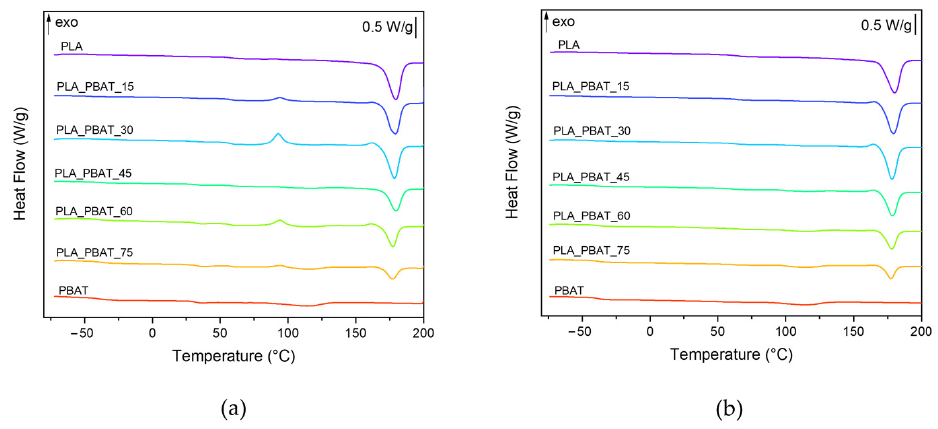
Figure 6. DSC thermograms of neat PLA, neat PBAT and PLA/PBAT blends. ( a ) First heating scan, ( b ) second heating scan. Table 3. Results of the DSC tests on neat PLA, neat PBAT and PLA/PBAT blends (first and second heating scans).